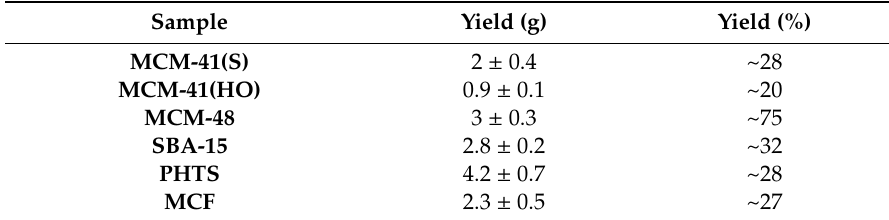
Table 1. Yields of all the synthetized